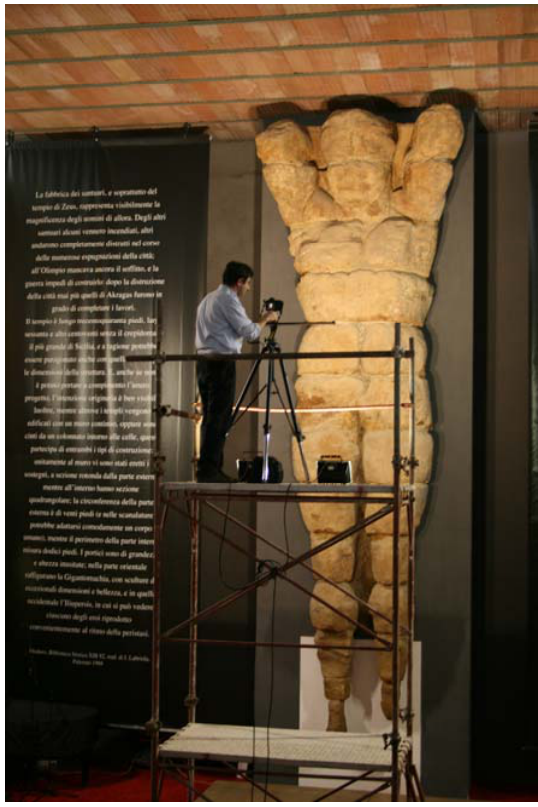
Figure 8. Photogrammetric data acquisition